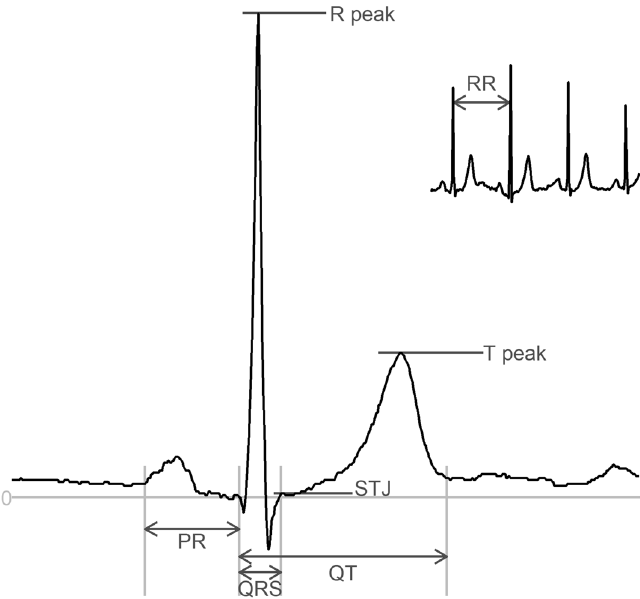
Figure 4. An ECG complex with the nomenclature of intervals (QT, QRS, P duration) and Amplitudes (STJ, R, T) and RR-interval (which can be converted to heart rate (HR) as HR = 60/RR interval.